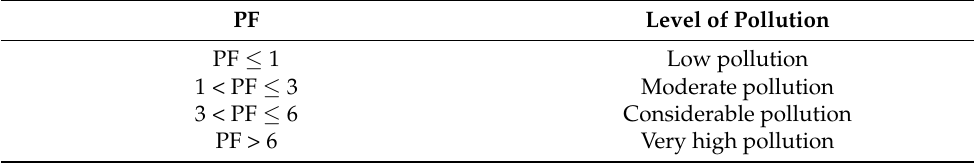
Table 2. PF with different classifications.